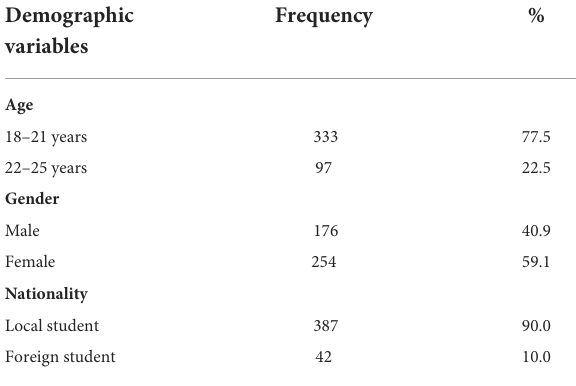
TABLE 1 Demographic characteristics of the respondents ( n =